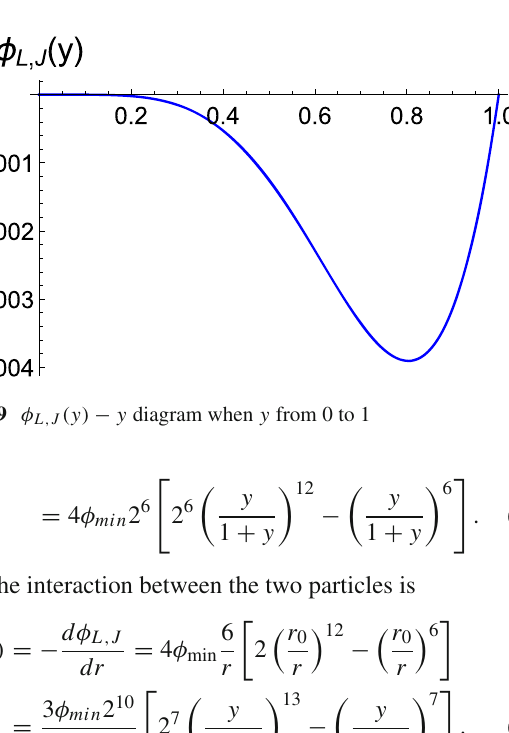
Fig. 8 F − x diagrams when the parameters change respectively and the initial parameters m = 2 . 12, c 1 = 2, c 2 = 3 . 18, q = 1 . 7, r c = 1, k = 1